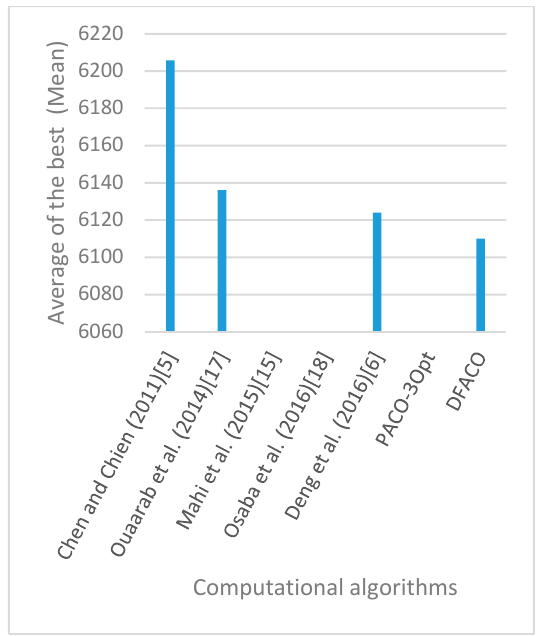
Figure 13. Average of best solutions obtained for instance ch130 by all algorithms.